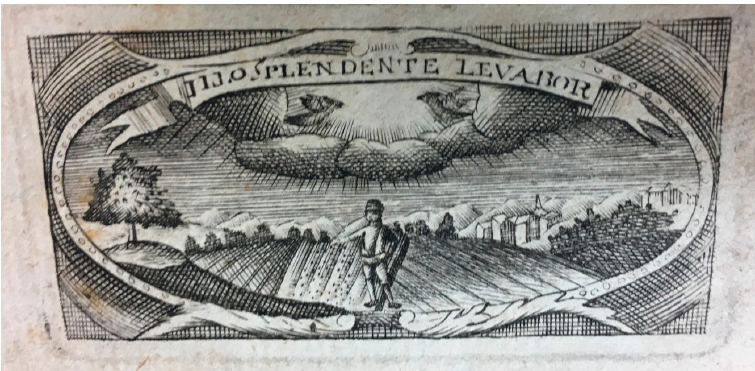
Figure 4. A 1731 version of the seal (Francke 1731). August Hermann Francke. Erklaerung der Psalmen